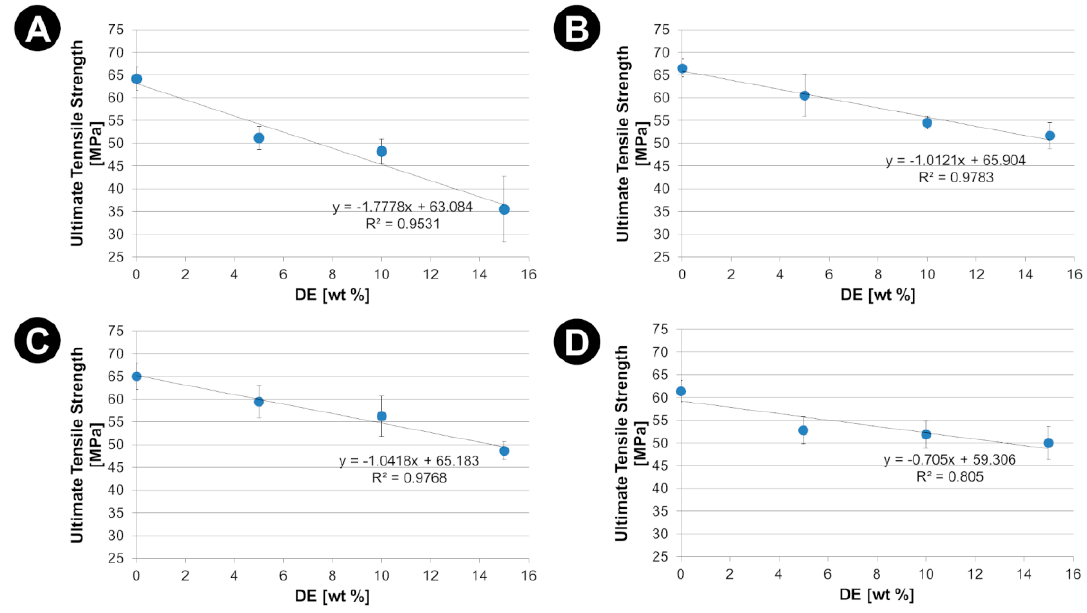
Figure 7. Ultimate tensile strength (R m ) against the DE content for PLA-DE composites with ( A ) 2003D; ( B ) 3001D; ( C ) 3251D and ( D ) 4043D PLA as a matrix.